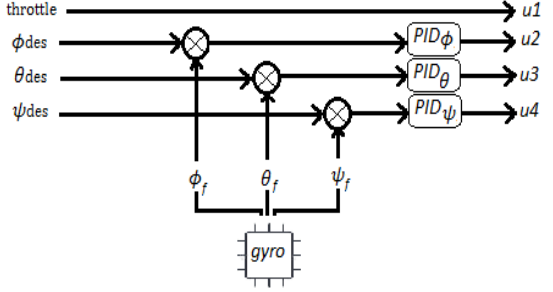
Figure 8. PID control systems Frame parameters